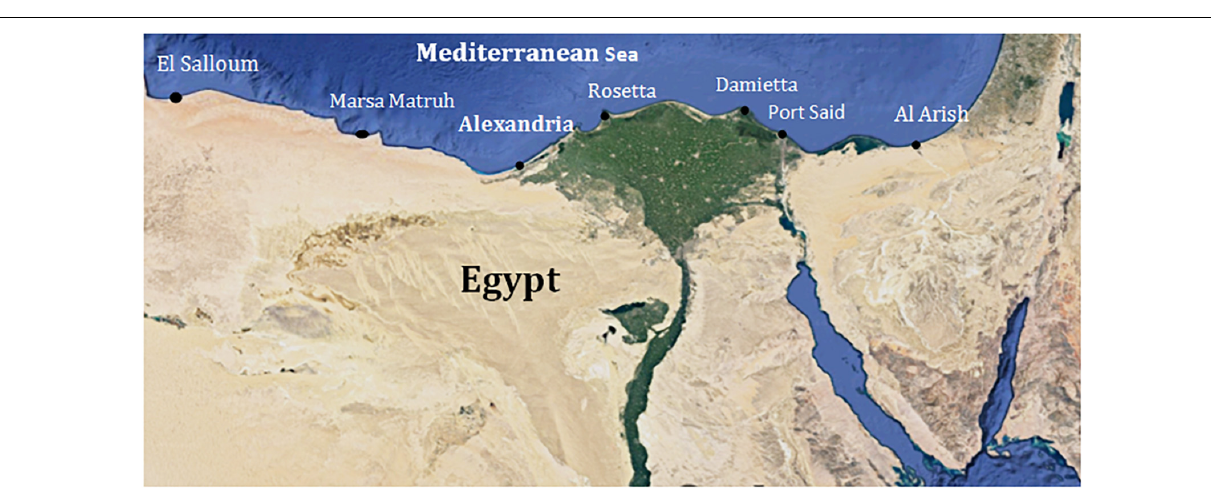
FIGURE 2 | Eastern Mediterranean, Egypt (GSA 26) showing the main landing